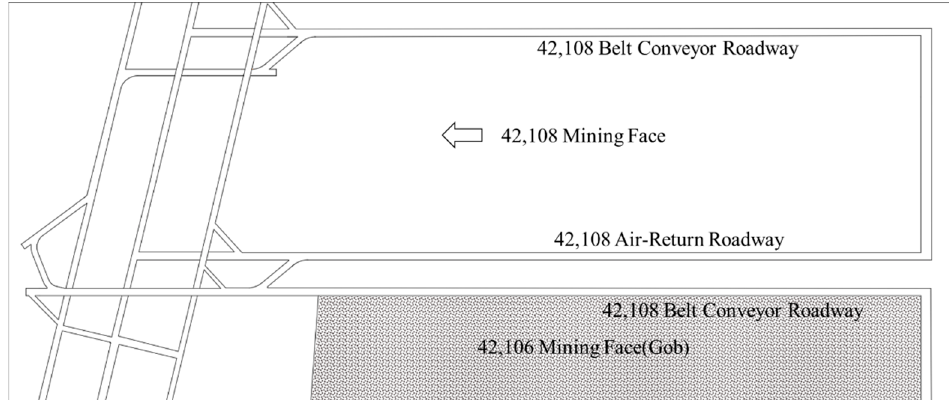
Figure 2. Longwall working face 42,108 and roadway layout plan.